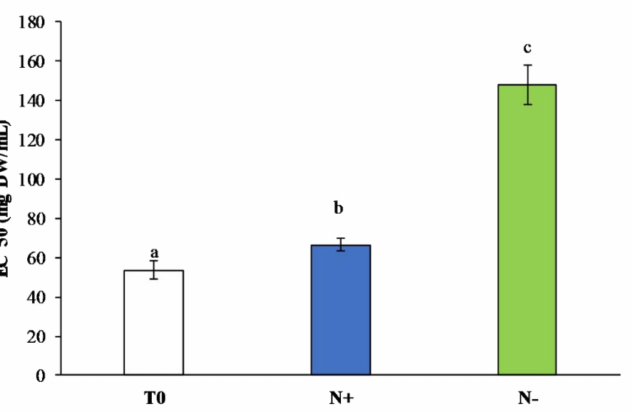
Figure 8. Reducing power (EC50, mg DW/mL) in P. tricornutum extracts cultivated for 15 days under initial culture conditions (T0, white bar), under standard conditions (N+, blue bar), and under starvation conditions (N − , green bar). Values are reported as the means ( n = 3), and error bars report the standard deviations. Treatments that do not share the same letter were significantly different from each other ( p <